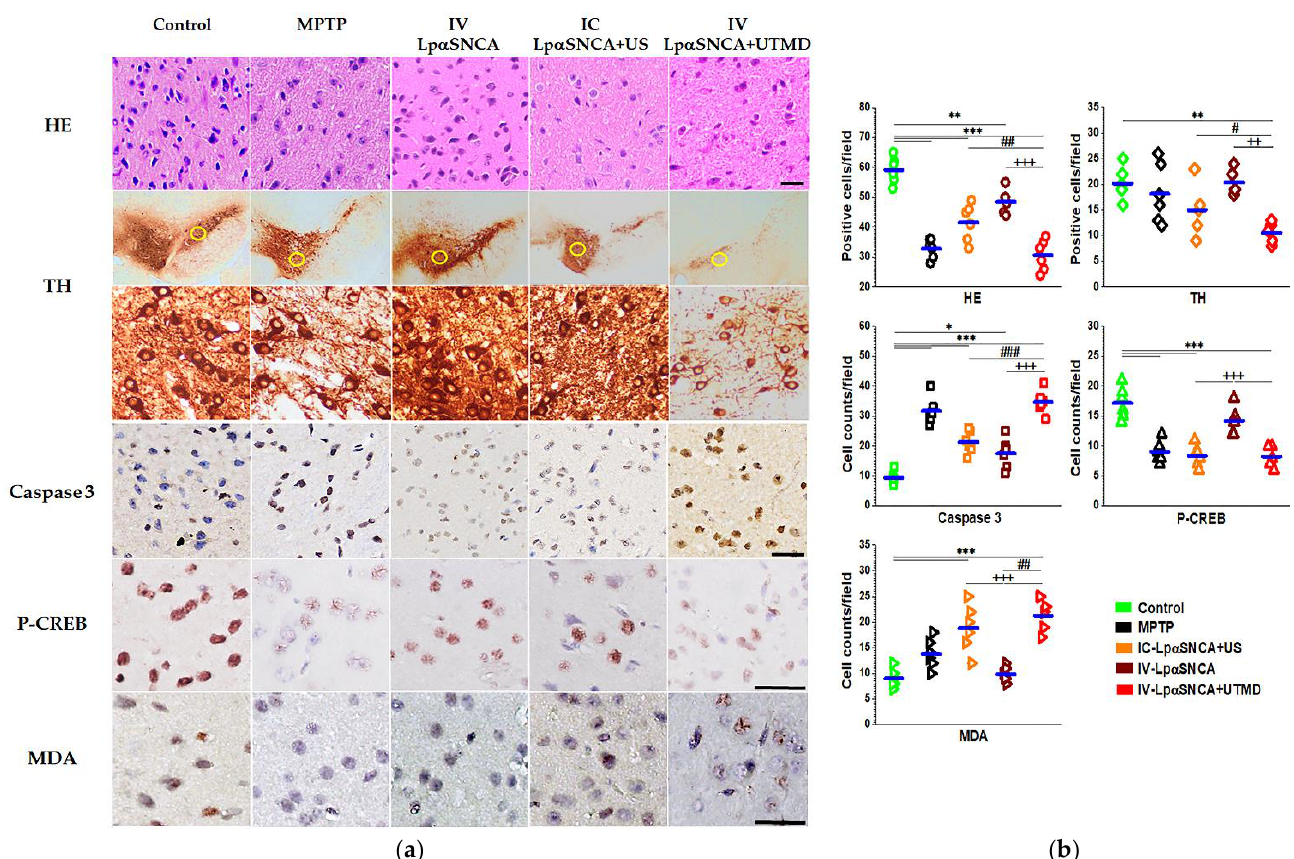
Figure 5. ( a ) Microscopic observation of histological damage, HE staining, TH, caspase 3, P-CREB, and MDA numbers with the control and PD groups (MPTP, IC with Lp α SNCA (10 μ g pDNA), and IV with Lp α DNA (60 μ g pDNA) +/ − UTMD). TH immunostaining of the control and PD groups (magnification, ×40; high magnification, ×400). Scale bars = 100 μ m. ( b ) Bar graphs represent the mean ± standard deviation, and statistical analysis was performed via ANOVA with the post hoc Tukey test. *, **, and *** indicate p < 0.05, p < 0.01, and p < 0.005 vs. the control group; # , ## , and ### indicate p < 0.05, p < 0.01, and p < 0.005 vs. the IC-Lp α SNCA + US group; ++ and +++ indicate p < 0.01 and p < 0.005 vs. the IV-Lp α SNCA group; n ≥ 3 for each group. MPTP = 1-methyl-4-phenyl-1,2,3,6- tetrahydropyridine; IC = intracerebral; IV = intravenous; US = focused ultrasound; UTMD = focused ultrasound-targeted microbubble destruction.